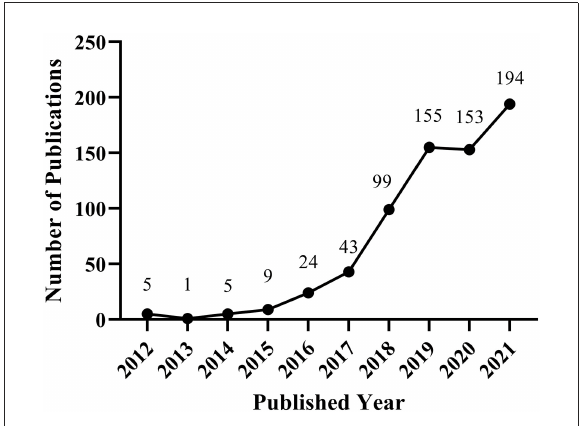
FIGURE1 The number of publications on fusion of sports and medicine in China from 2012 to 2021.